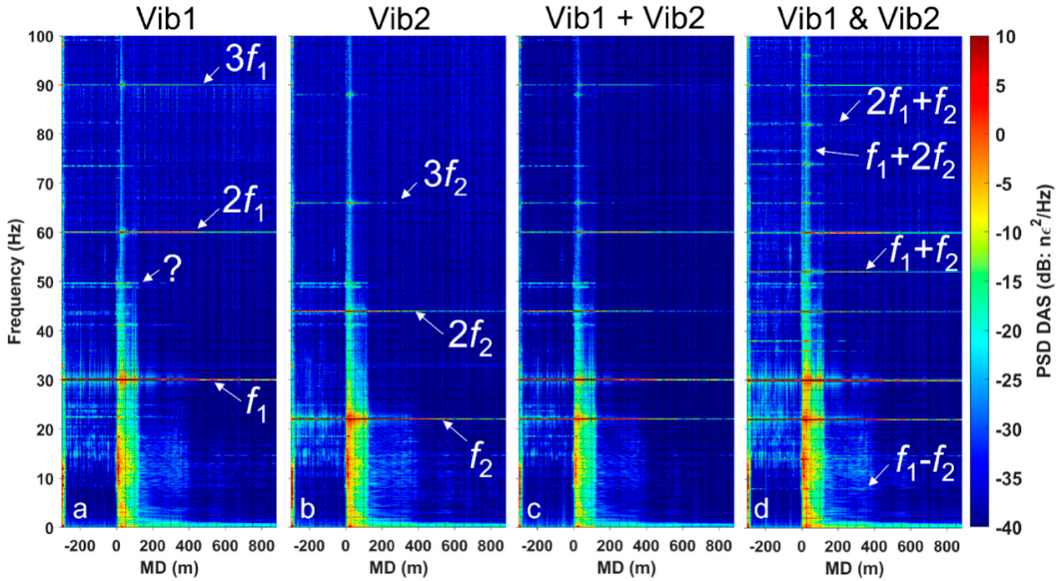
Figure 2. Spectrograms of the recorded data: ( a ) Vibrator 1 working solo; ( b ) Vibrator 2 working solo; ( c ) the signals from the two vibrators working solo summed up to simulate their linear superposition; ( d ) two vibrators working simultaneously. The measured depth (MD) starts at the wellhead and its negative values correspond to the part of the cable coiled around the well on the surface.